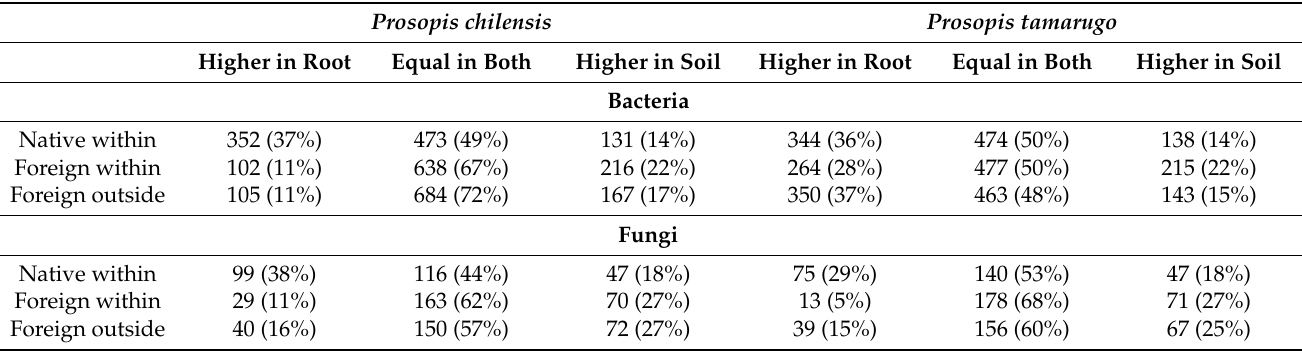
Table 2. Bacterial and fungal root-associated community by Prosopis chilensis and P. tamarugo relative to the ASV abundance in the soil. ASVs with higher abundance in the roots were considered as root associated. Values correspond to the number of ASVs. Value between brackets corresponds to relative proportion in the community, in percentage (%). Prosopis chilensis Prosopis